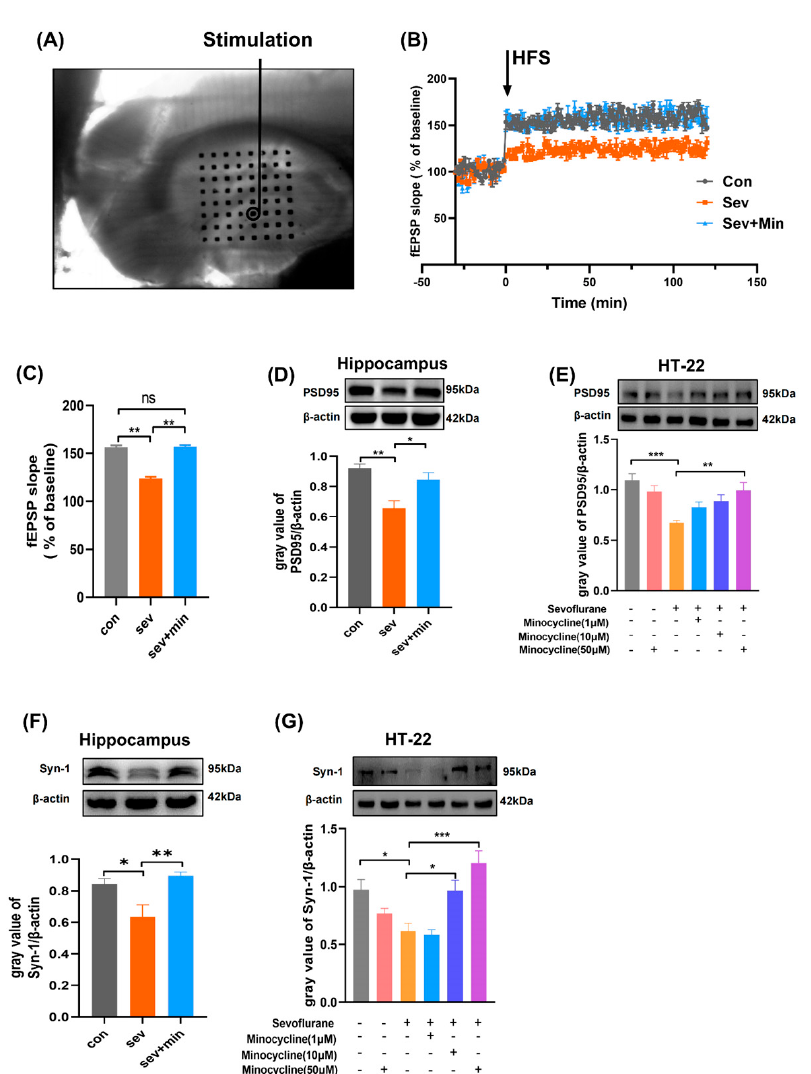
Figure 2. Minocycline attenuates sevoflurane-induced synaptic plasticity impairment. ( A ) Schematic representations of the stimulation sites in the hippocampal DG region and the microelectrode array (electrode size, 50 × 50 µ m; interpolar distance of the electrode, 150 µ m). HFS induced LTP in the DG region of the hippocampus. fEPSP slopes ( B , C ) in DG neurons in the hippocampus induced by the Schaffer collateral pathway. Data are mean ± SD ( n = 3). ns, no significance; ** p < 0.01. ( D – G ) WB detection of PSD95 and Syn-1 expression levels in HT-22 cells and hippocampal tissue specimens. β -actin was utilized for normalization. ImageJ was employed for quantitation. Data are mean ± SEM. * p < 0.05, ** p < 0.01, *** p < 0.001.